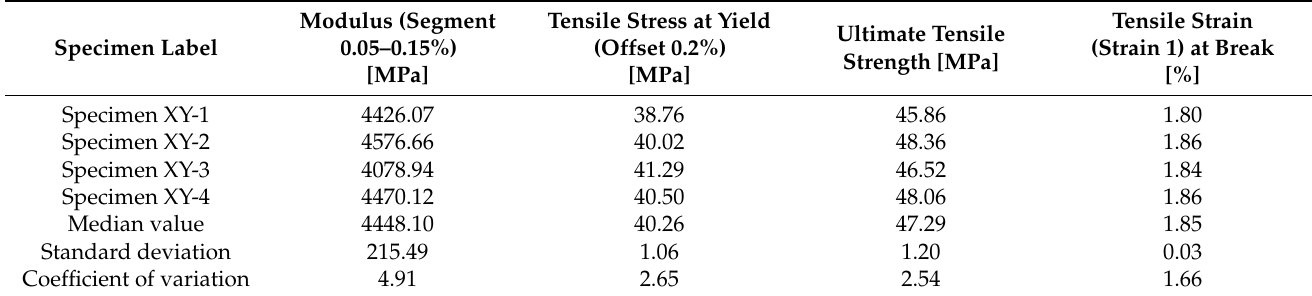
Table 4. Mechanical characteristics obtained for the XY specimens.